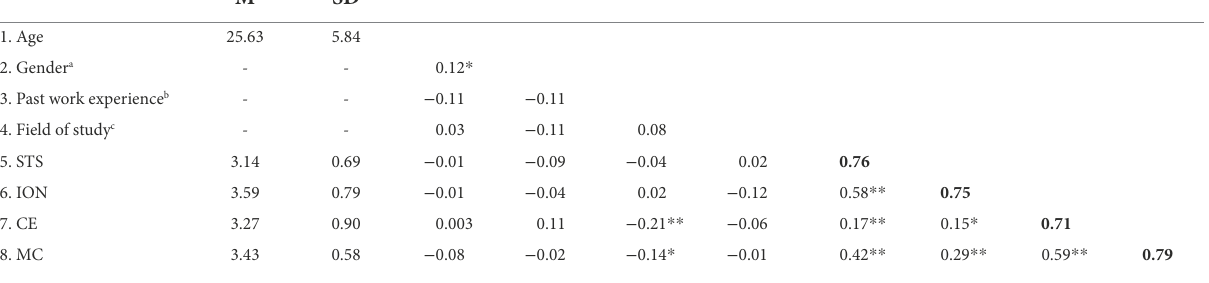
TABLE 2 Correlations, means, and standard deviations.